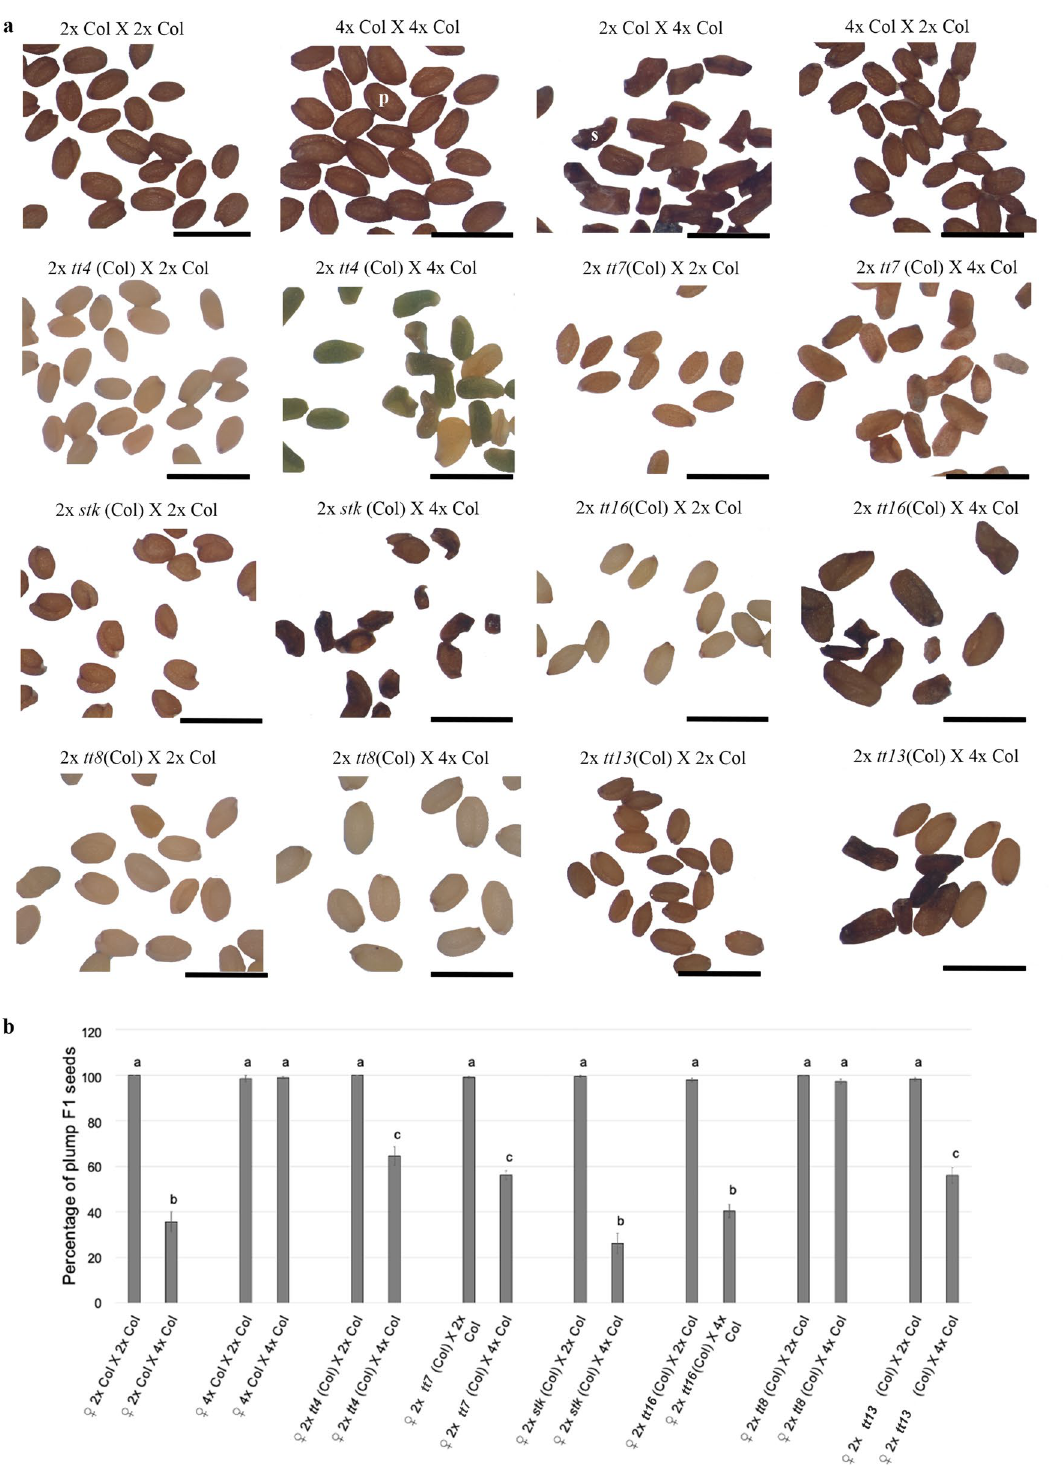
Figure 2. F1 seed shape of different FBP related mutants in interploidy crosses. ( a ) Mature F1 seeds obtained crossing FBP mutants in balanced and paternal-excess crosses. Wildtypes are shown on the first row. ( b ) Percentage of plump F1 seeds. Data are presented as means ± standard error. 200–300 F1 seeds were analyzed for each cross. Pooled data of three independent assays performed with 3 replicates for each measurement. One- way ANOVA followed by Tukey HSD test was used for analyzing significance. tt4 is tt4 - 11 ; tt7 is tt7-2 ; stk is stk-2 ; tt16 is tt16-7 ; tt8 is tt8-6 ; tt13 is tt13-6. Crosses marked with the same lowercase letter display no statistical difference. p: plump seeds; s: shriveled seeds, Col = Col-0. Scale: 1 mm ( a